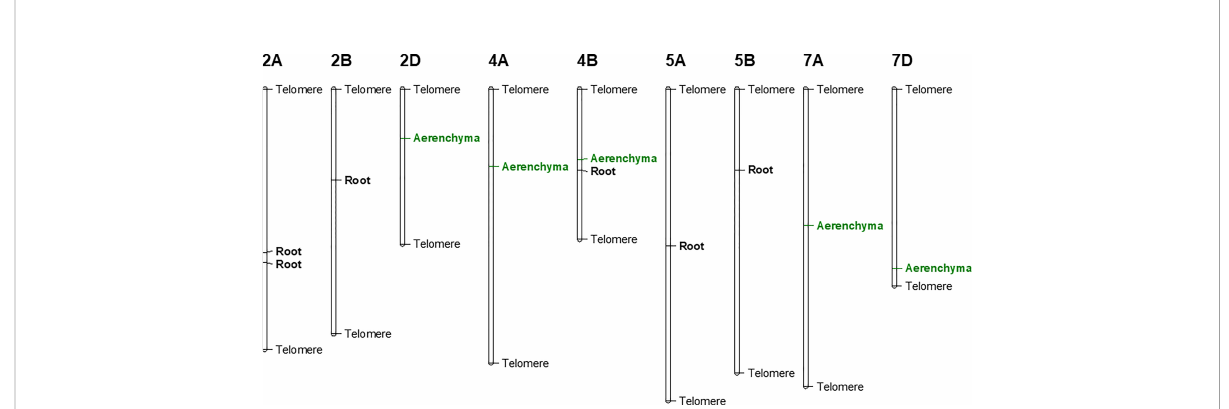
FIGURE 4 Genetic linkage map of identi fi ed MTAs. Root: markers associated with root survival under waterlogging condition; Aerenchyma: markers associated with aerenchyma formation under waterlogging